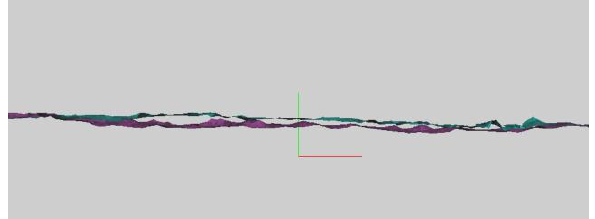
Figure 9. Section of road surface 3D model before and after loading experiment